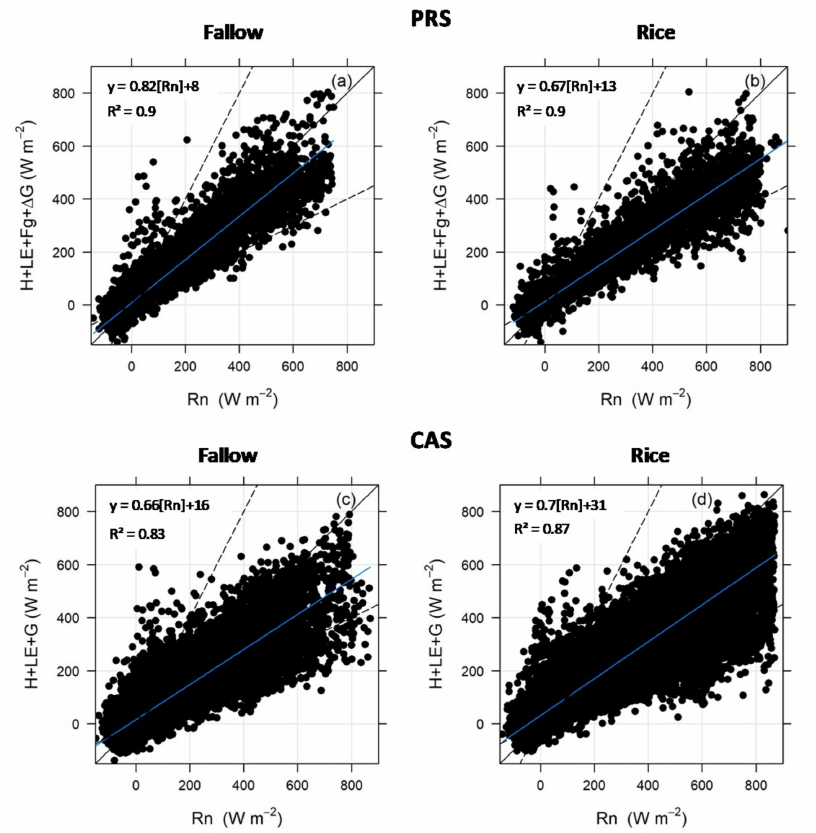
Figure 2. Scatterplots of the 30-min energy balance closure computed for fallow (non-flooded) ( a , c ) and irrigate seasons ( b , d ) at the PRS ( top ) and CAS ( bottom ) sites. The solid blue lines represent the linear fit of the data. The equations of the lines and R 2 (coe ffi cient of determination) value are also shown. For reference, the 1:1 line is a solid black line and the 1:0.5 and 1:2 lines are